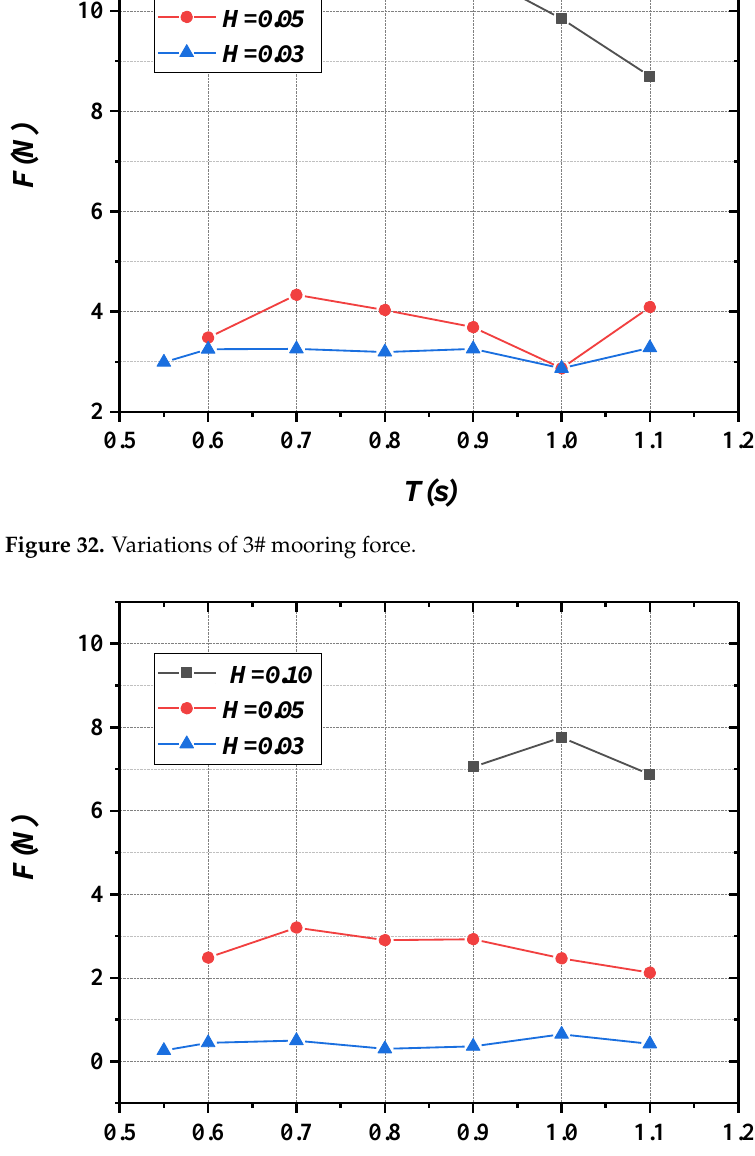
Figure 33. Variations of 4# mooring force.